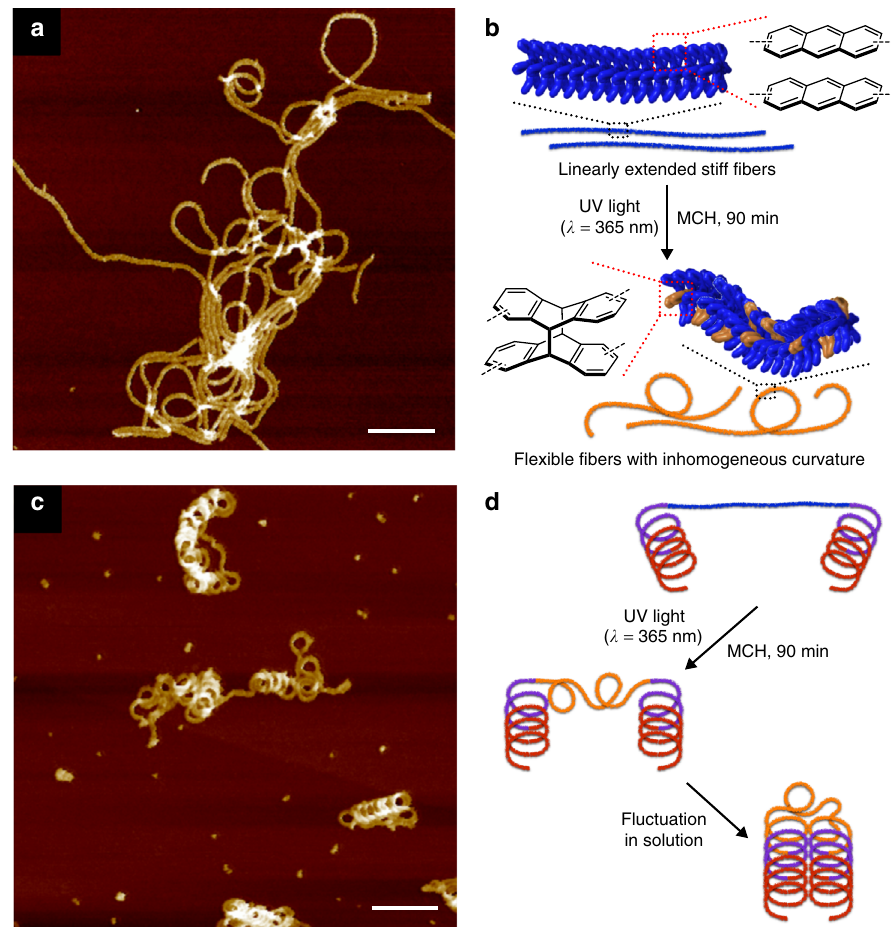
Fig. 6 UV-induced morphology changes in Ant fi bers and chimeric fi bers. a AFM image of Ant fi bers after 90 min of irradiation with UV light ( λ = 365 nm) in MCH at 293 K. The original linear fi bers were prepared by cooling a hot MCH solution of Ant ( c = 1.0 × 10 − 5 M) from 373 to 293 K using a cooling rate of 1.0 K min − 1 (scale bar, 100 nm). b Schematic representation of the topology changes upon UV irradiation of Ant fi bers. c AFM image of chimeric fi bers after irradiation with UV light ( λ = 365 nm) in MCH at 293 K for 90 min. The original chimeric fi bers were prepared by cooling a hot MCH solution of a 1:1.5 mixture of Ant ( c = 1.0 × 10 − 5 M) and Nap ( c = 1.5 × 10 − 5 M) from 373 to 293 K using a cooling rate of 1.0 K min − 1 (scale bar, 100 nm). d